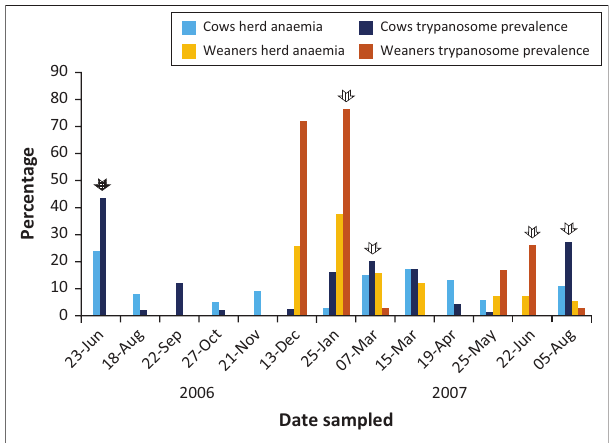
FIGURE 2: Trypanosome prevalence ( % ) and herd anaemia ( % ) for cows, and weaners at Boomerang Farm from 23 June 2006 to 05 August 2007. Dark arrow indicates ethidium treatment and striped arrow indicates novidium treatment of cattle.